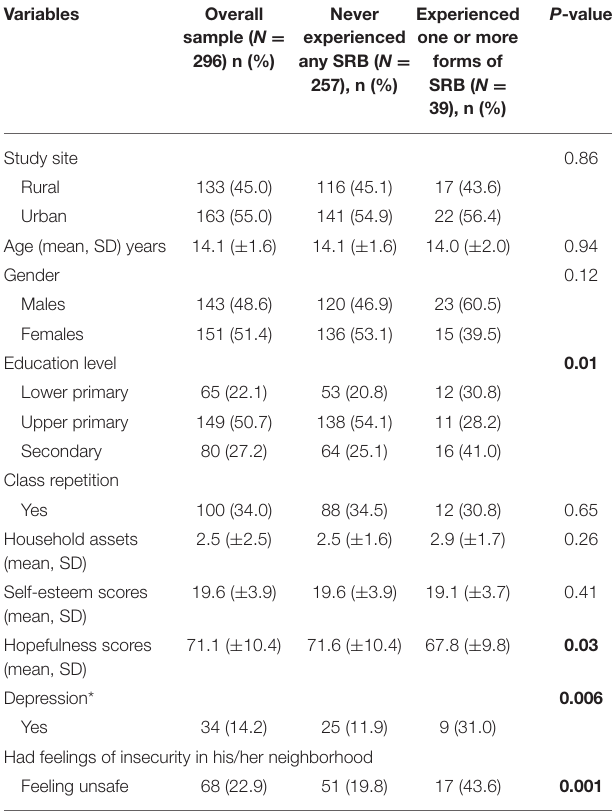
TABLE 1 | Socio-demographic and psychosocial characteristics of the adolescents summarized by experience of sexual risk behavior.